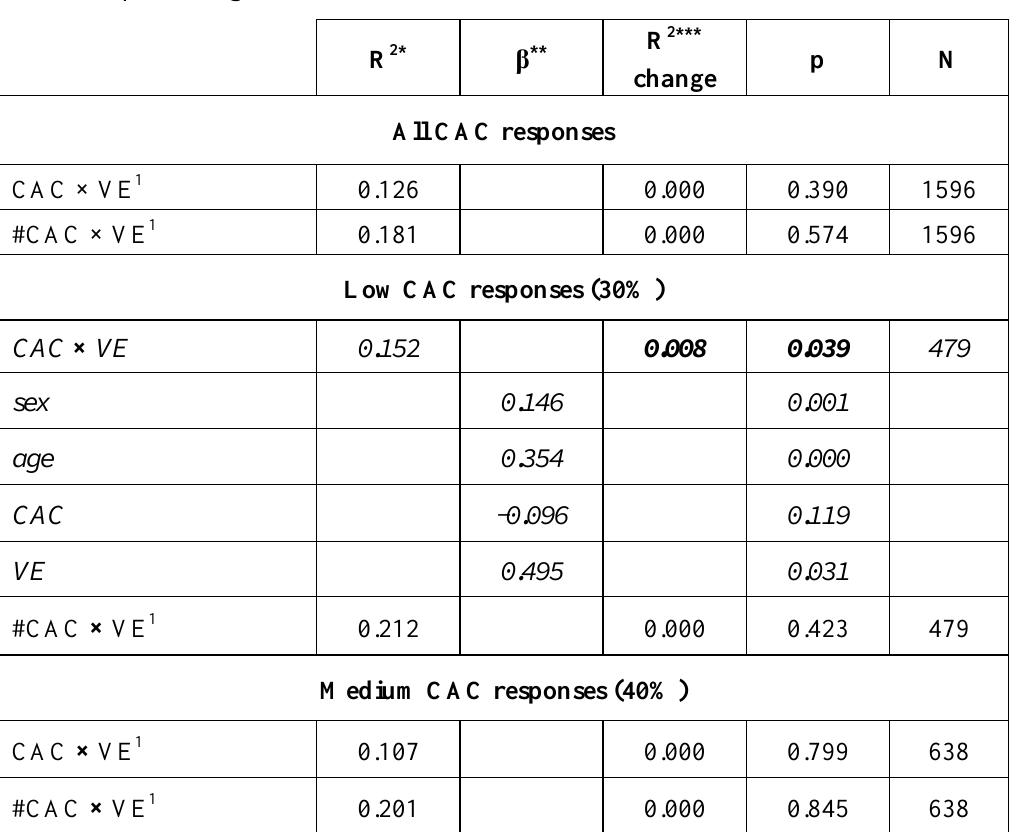
Table 5. Regression analysis of interactions between carotid artery compliance and vital exhaustion in predicting